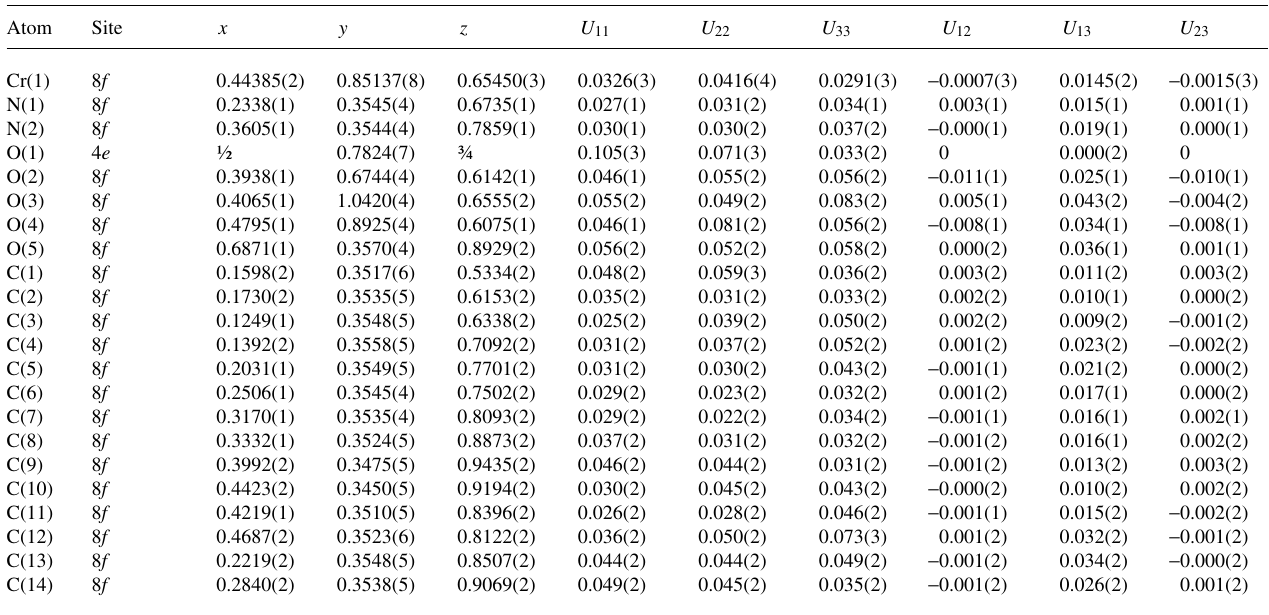
Table 3. Atomic coordinates and displacement parameters (in Å 2 )